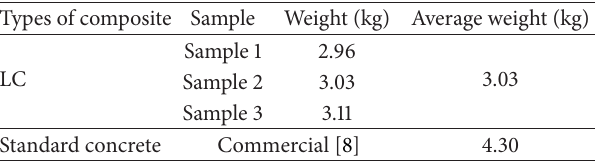
Table 5: Weight average of LC and standard commercial cube con-